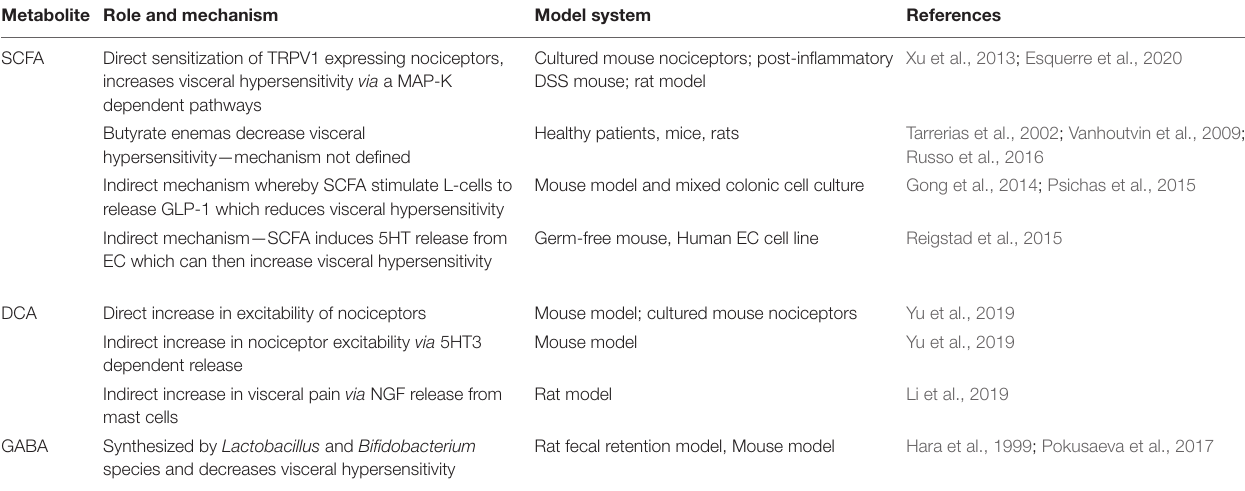
TABLE 1 | Role of microbial metabolites in visceral